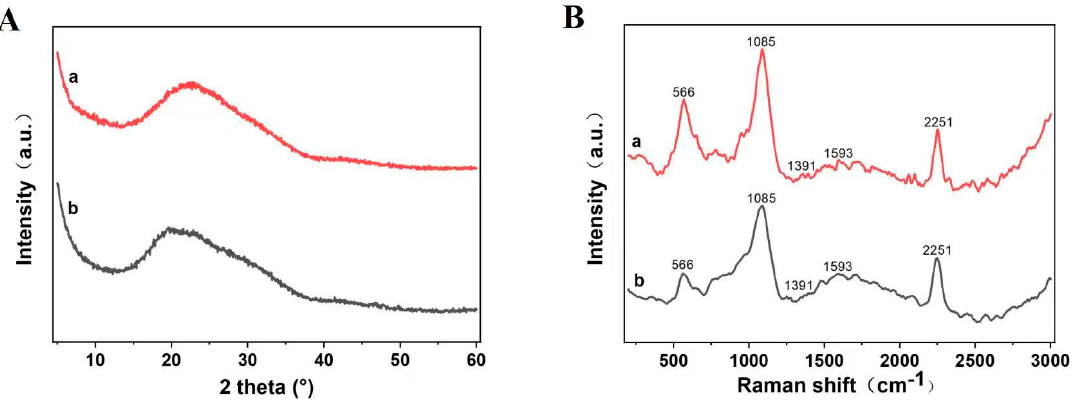
Figure 6. ( A ) XRD pattern and ( B ) Raman spectrum of Taxus cuspidata . (a) crude Taxus cuspidata , (b) recrystallization